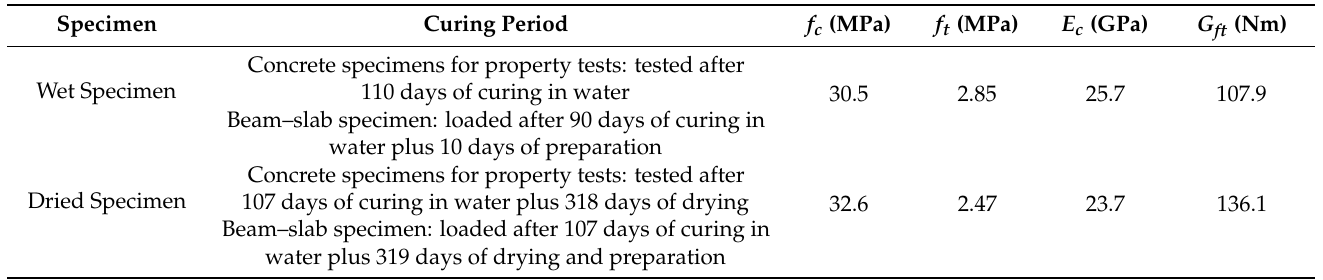
Table 2. Concrete properties.